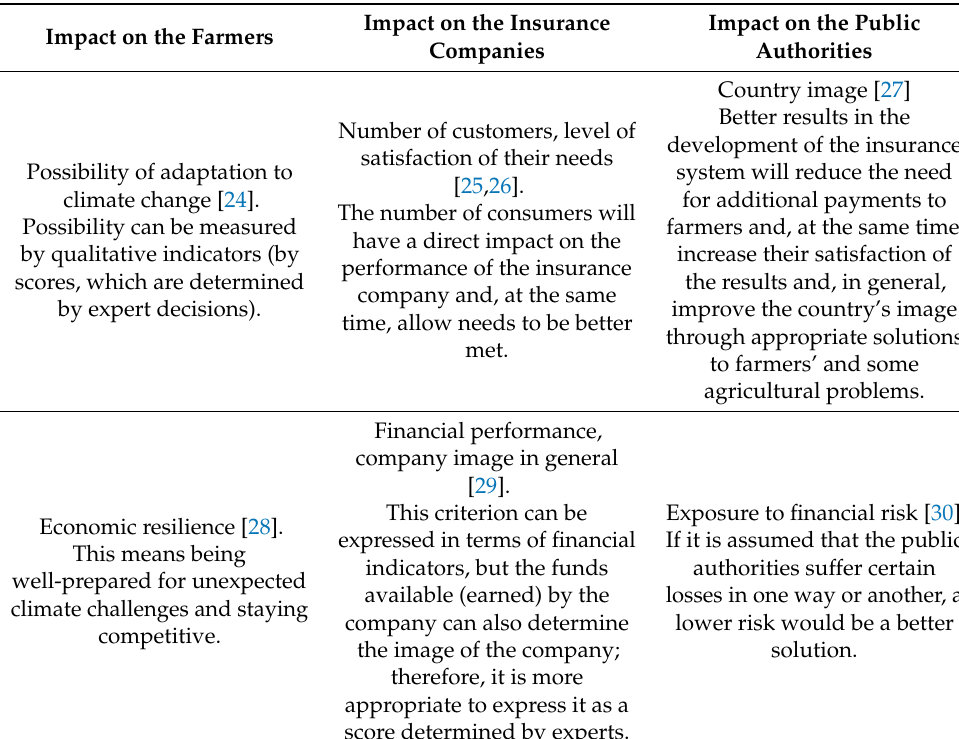
Table 1. Criteria for assessment of the direction of activity development for public authority according to impact on the components of insurance